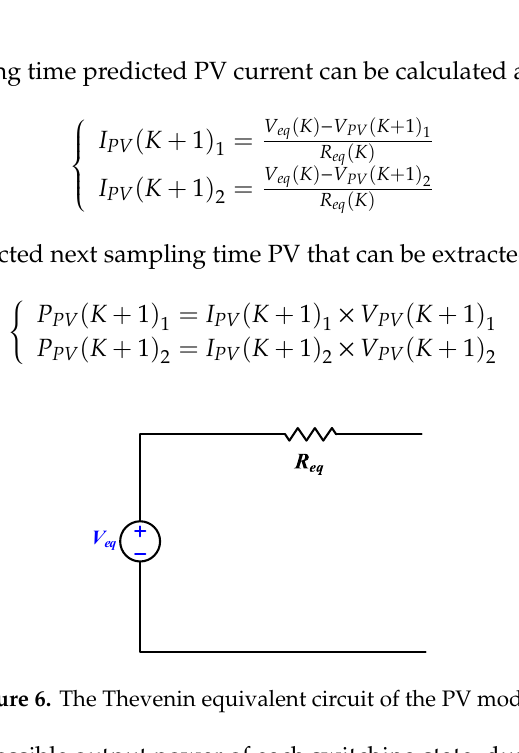
6 of 15 Figure 5. Block diagram of the proposed fixed frequency phase-shift MPPT predictive control. Step 2 : The next sampling time of the PV terminals voltage (cid:1848) (cid:3017)(cid:3023) ((cid:1837) + 1) and the PV current (cid:1835) (cid:3017)(cid:3023) ((cid:1837) + 1) are predicted. In order to reduce the number of sensors, a digital observer is used. Figure. 6 presents the equivalent circuit of PV module using the Thevenin theorem. Designed digital observer is presented to calculate the required equivalent voltage ( (cid:1848)(cid:1857)(cid:1869) ) and the equivalent resistance ( (cid:1844)(cid:1857)(cid:1869) ) as